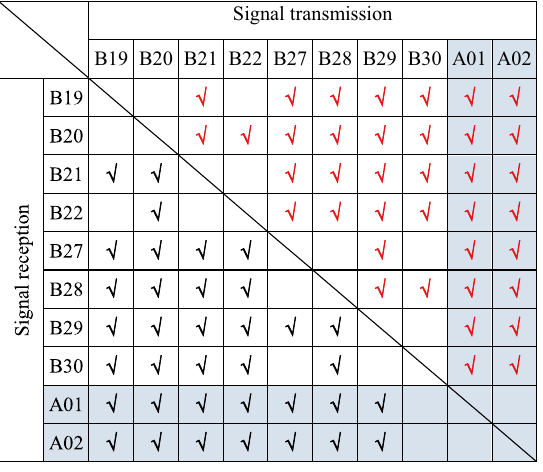
Table 1 Measurement relationships between satellites or between satellites and anchor stations Signal